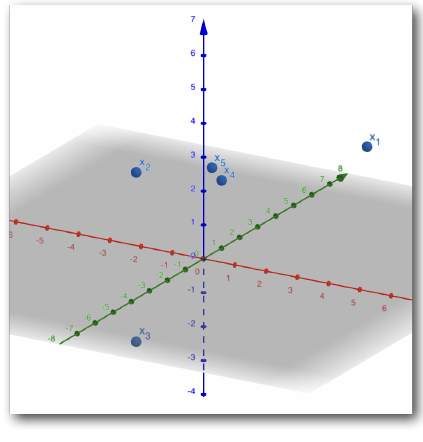
Figure 1. x = x 1 , x 2 , x 3 , x 4 , x 5 ∈